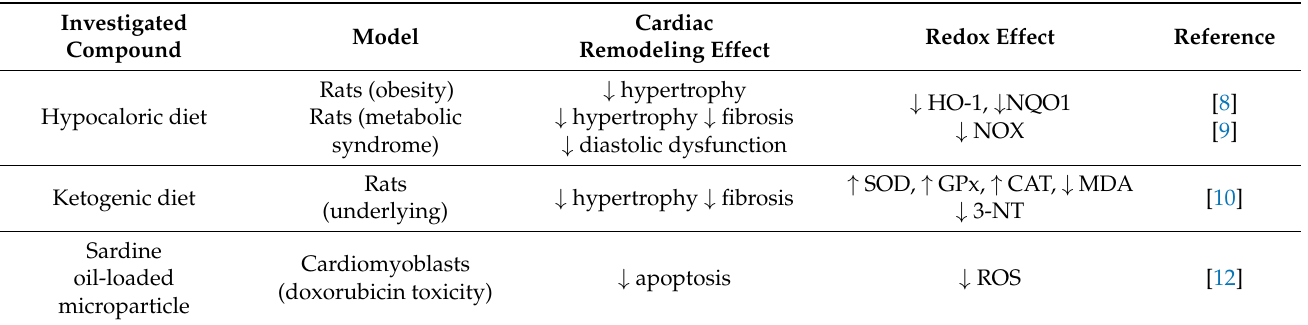
Table 1. Diets, macro-, and micronutrients investigated regarding their potential therapeutic antioxi- dant effects on cardiac